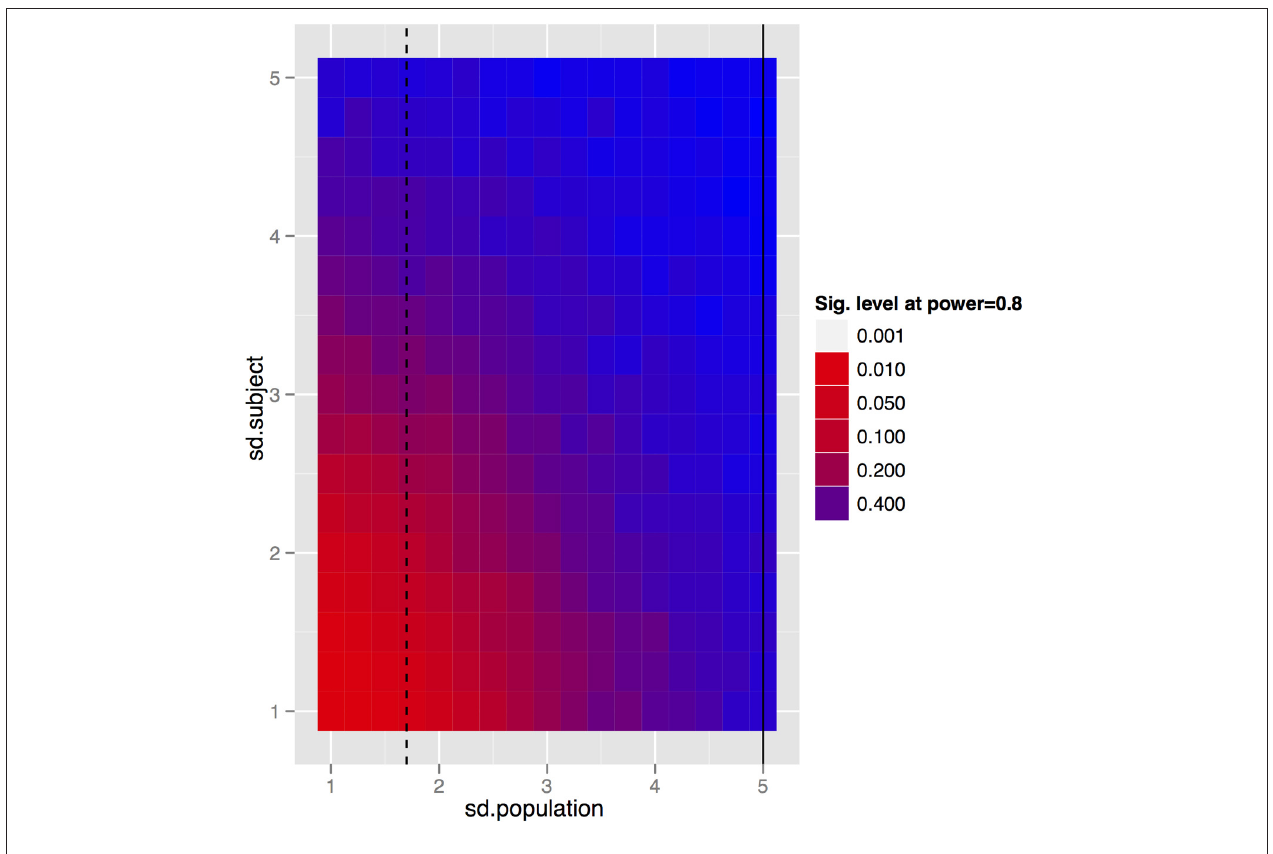
FIGURE 7 | The trade-off between subject and population standard deviations (given in % volume) for the fixed-brain experiment. In the basic fixed-brain experiment we assumed that there was no subject variance (i.e., all within subject variance was